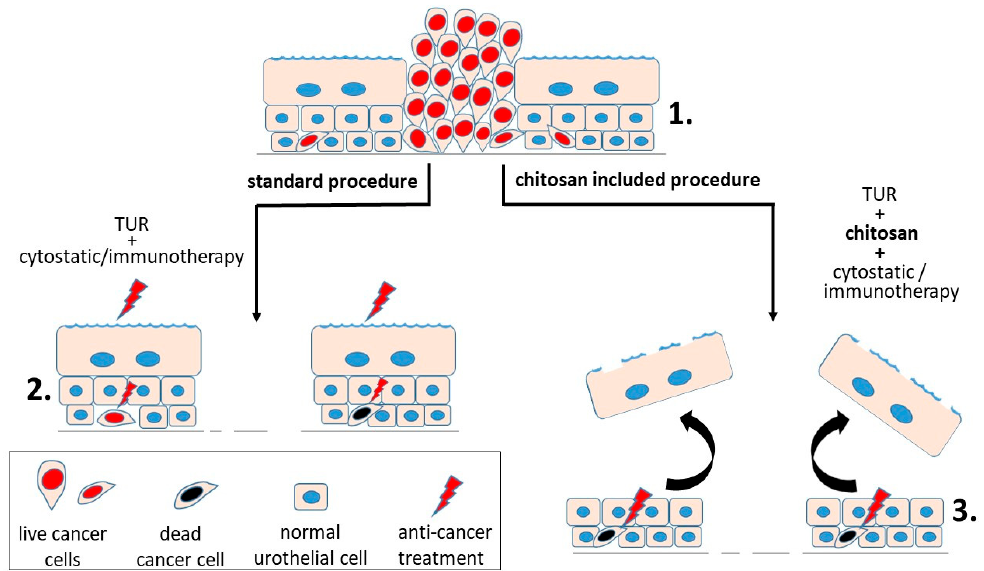
Figure 4. Two procedures to treat non-invasive urinary bladder cancer. (1) Urinary bladder cancer cells persist in the urothelium in tumours and as individual migrating cancer cells. (2) Standard procedure in treatment of non-invasive urothelial tumours is transurethral resection (TUR) of tumours and subsequent chemo- or immunotherapy. Frequently, individual cancer cells survive such treatment because of the diffusion-limiting blood-urine barrier. (3) Combined treatment with TUR removing tumour mass, chitosan compromising the barrier function, and immunotherapy more efficiently destroys even remote cancer cells.